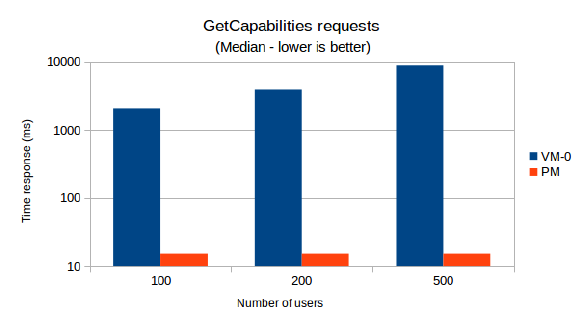
Figure 7. Median response time in milliseconds for the GetCapabilities request with 100, 200 and 500 concurrent users both for the VM-0 and PM.